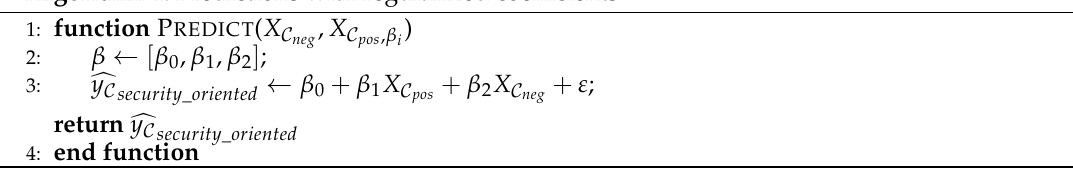
Table 3. Identified Twitter accounts related to hacking and cyber